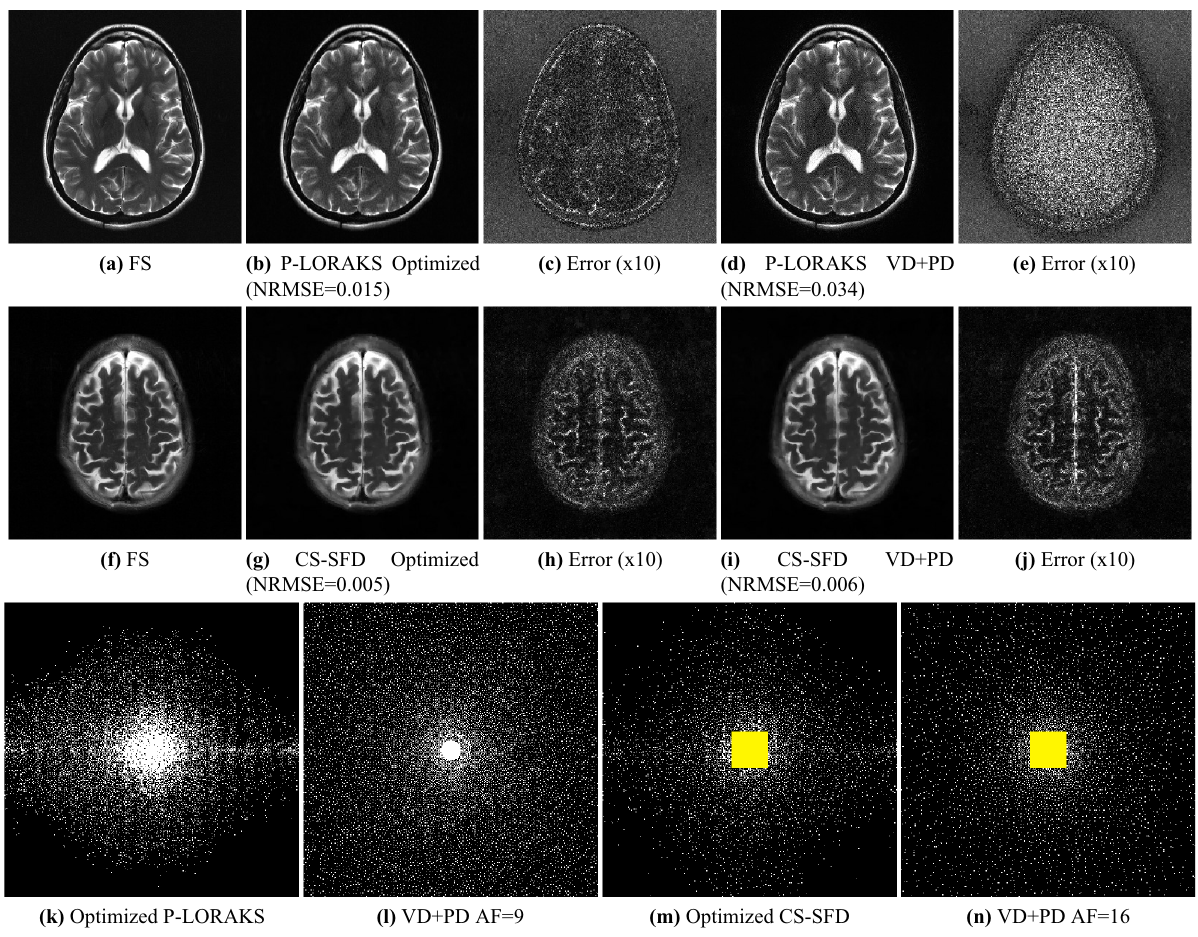
Figure 6. Visual results of the T 2 -brain dataset are shown in this figure. For P-LORAKS, fully sampled (FS) reference is shown in ( a ), and images using optimized SP and combined variable density and Poisson disk (VD+PD) SP with AF = 9 are shown in ( b ) and ( d ). Error maps between FS and P-LORAKS are shown in ( c ) for Optimized SP and ( e ) for VD + PD SP. For CS-SFD, FS reference is shown in ( f ), and images using optimized SP and VD + PD SP with AF = 16 are shown in ( g ) and ( i ). Error maps between FS and CS-SFD are shown in ( h ) for Optimized SP and ( j ) for VD+PD SP. The optimized and VD+PD SPs with AF = 9 for P-LORAKS are shown in ( k ) and ( l ), while the ones with AF = 16 used for CS-SFD, with the highlighted central-square auto- calibration region, are shown in ( m ) and ( n